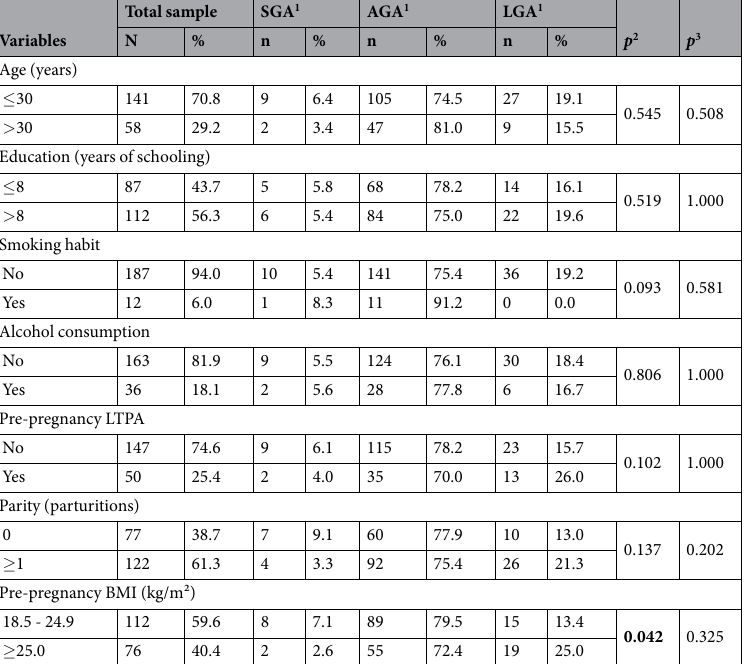
Table 2. Distribution of maternal characteristics according to birth weight categories in a sample of pregnant women and their newborns followed at a public health centre in Rio de Janeiro city, Brazil, 2009–2012. 1 Birth weight was classified according to the international foetal and newborn growth consortium for the 21 st Century (Intergrowth-21 st ) curves. 2 p-value refers to chi-square or Fisher’s exact test for proportions between AGA and LGA; 3 p-value refers to chi-square or Fisher’s exact test for proportions between AGA and SGA. AGA = adequate for gestational age; BMI = body mass index; LGA = large for gestational age; LTPA = leisure time physical activity; SD = standard deviation; SGA = small for gestational